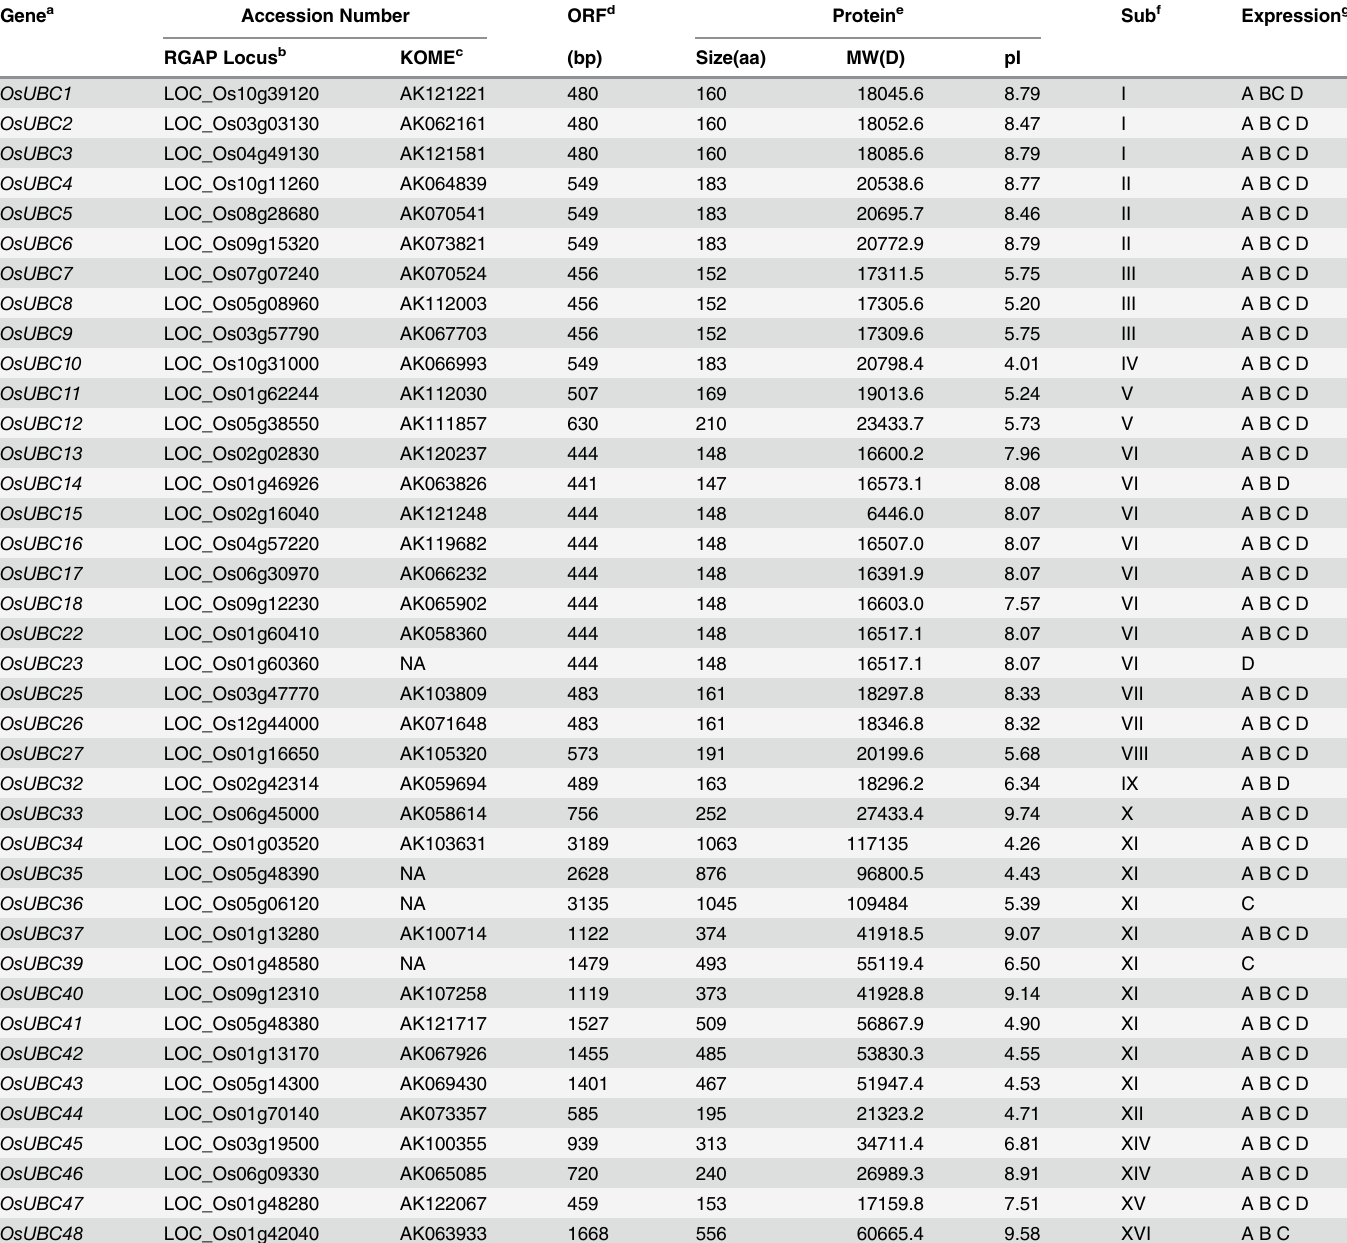
Table 1. The general information and sequence characterization of 39 OsUBC